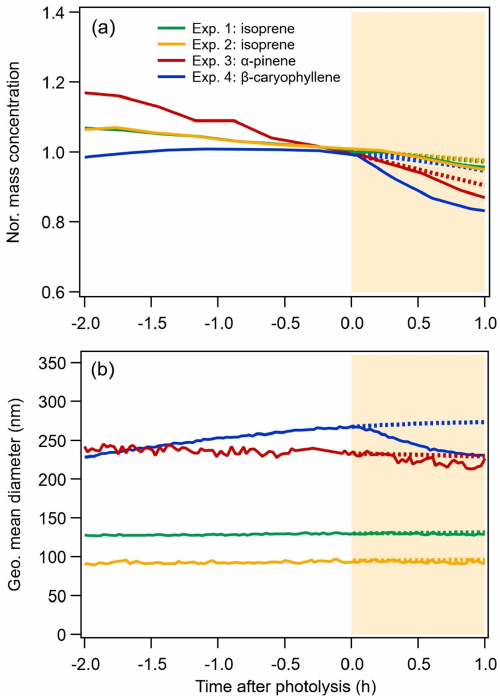
Figure 1. Time series of the normalized mass concentration (a) and geometric mean diameter (b) of the SOA measured by the SMPS. SOA mass loadings were corrected for particle wall losses based on the decay of the particle number concentration. The mass con- centration is normalized to the mass concentration value when the lights were turned on (time = 0 in the figure). The area shaded in yellow corresponds to the period of UV irradiation. The expected curvature of the mass concentration and geometric mean diameter without UV irradiation is represented by the dashed